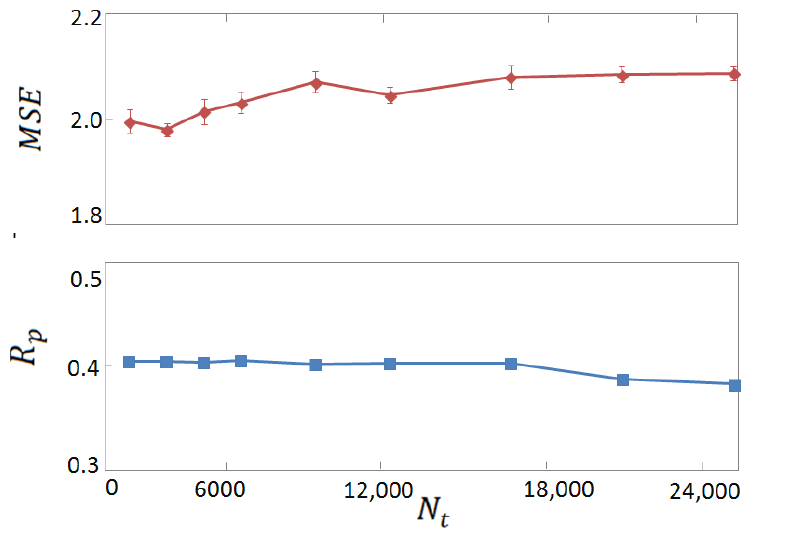
Figure 5. Mean squared error (MSE, upper panel) and R p score (lower panel) for binding affinity prediction in the vertical test, as a function of the training set size N t . The FCNN SFis trained on a computer-generated database including complexes made from 13 proteins, and tested on complexes made from four proteins not included in the training set.